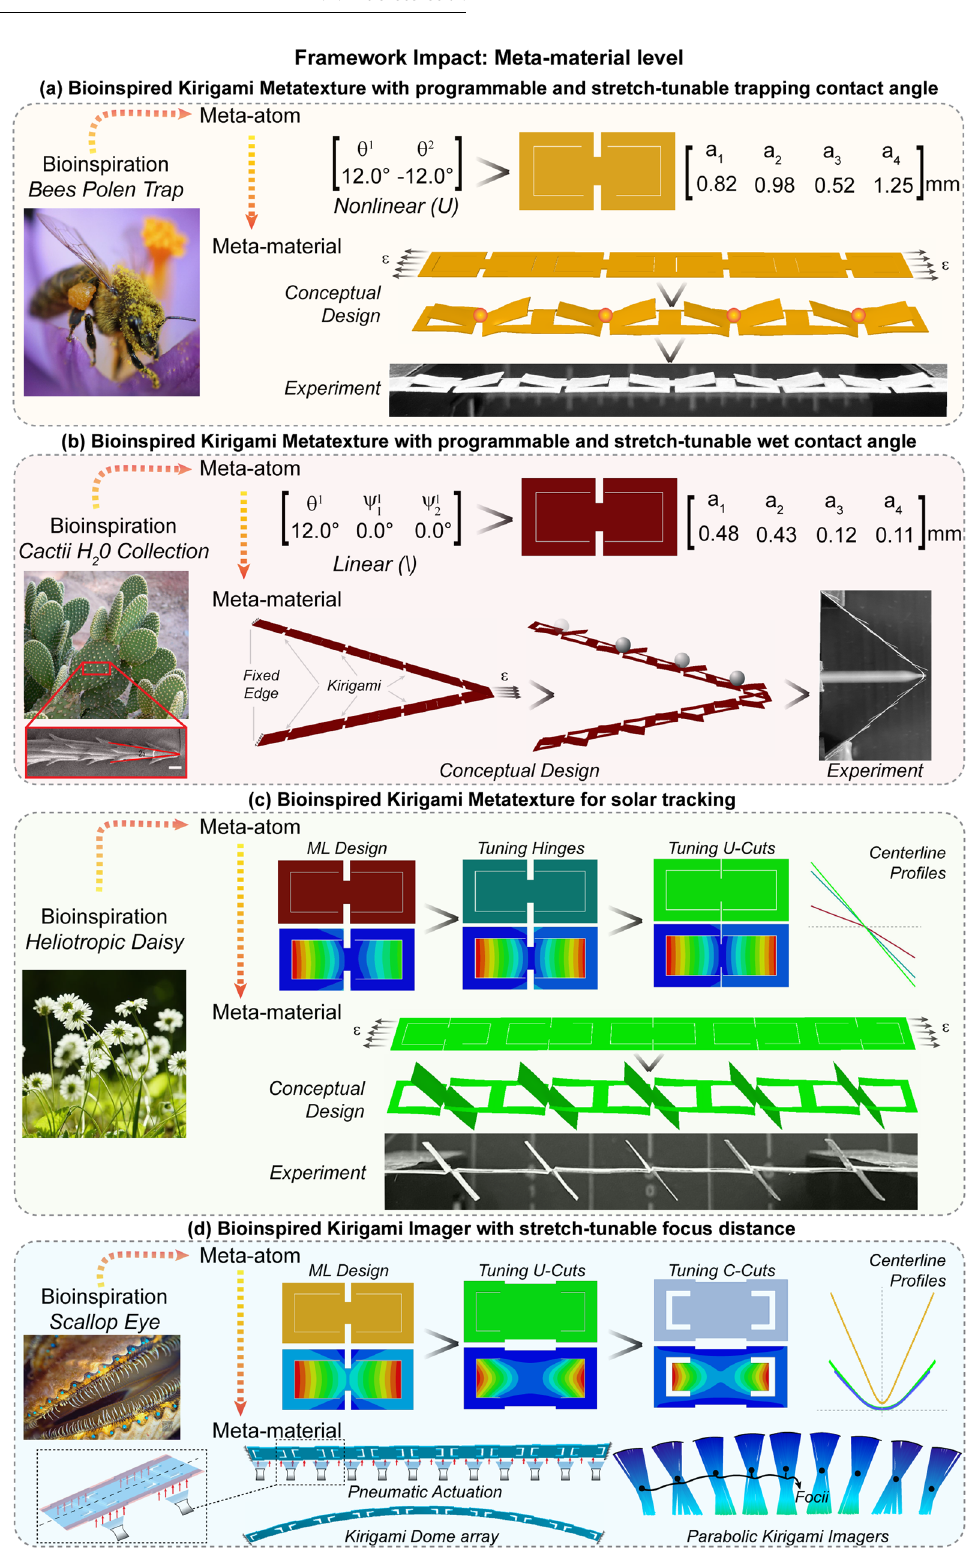
Fig. 7 Inverse design framework application and experimental validation at the metamaterial level. Photo credit: a Kirigami metatexture for tunable trapping. Photo of bee courtesy of Annette Meyer. b Kirigami metatexture for tunable wet contact angle. Optical photography by Stan Shebs, under CC BY-SA 3.0 license, and SEM micrograph adapted from ref. 24 . c Kirigami metatexture for solar tracking. Photo of daisies courtesy of jhening. d Kirigami metatexture for fl exible imagers. Photo of scallop courtesy of David Moynahan Photography. All pictures were used with permission from the authors or under an appropriate